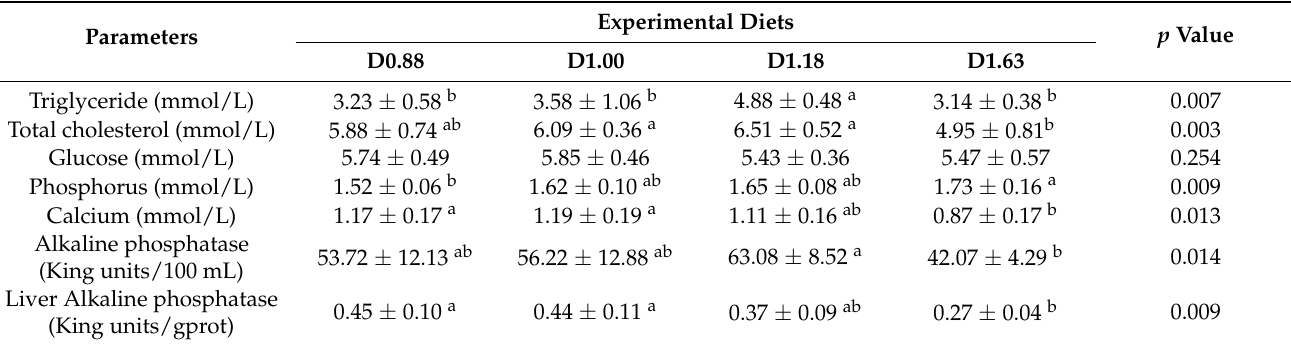
Table 6. Plasma physiological and biochemical parameters and liver alkaline phosphatase in Chinese soft-shelled turtle fed with different phosphorus diets.